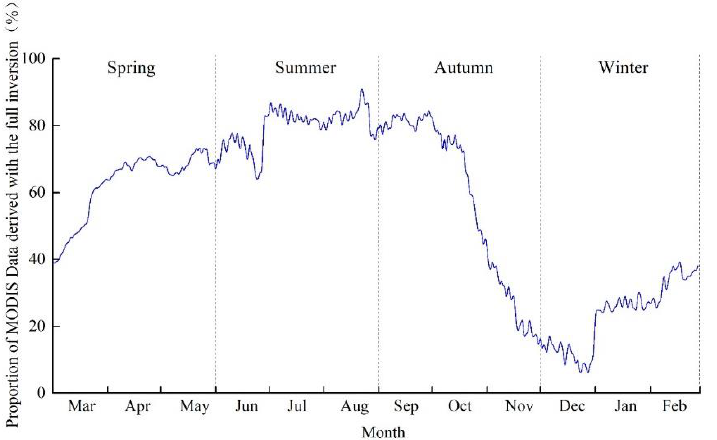
Figure 4. Proportion of MODIS Data derived with the full inversion over different seasons in 2016.